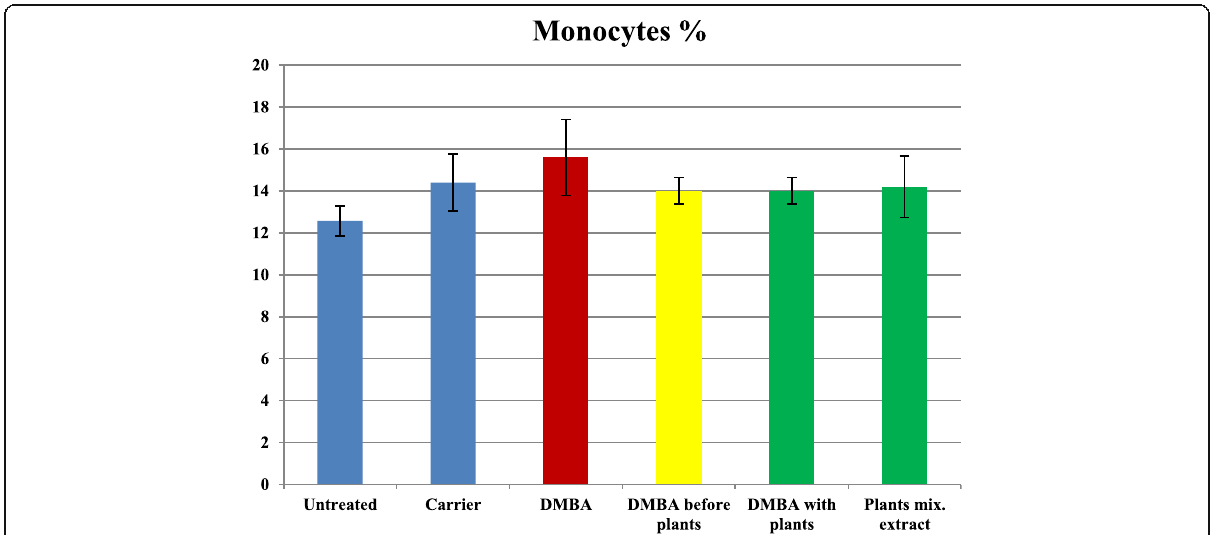
Fig. 6 Monocyte percentage in the different rat groups. Standard errors are indicated on the bars and the significance levels are shown in Table 1